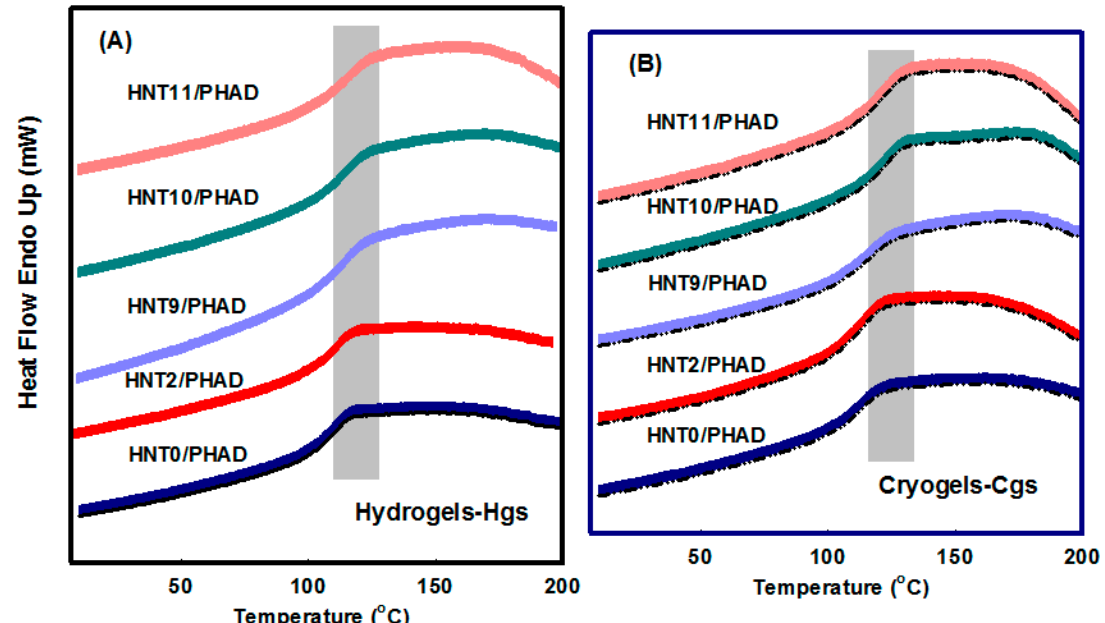
Figure 3. DSC curves of HNT-free, HNT0/PHAD, and ternary hybrid HNTm/PHAD Hgs ( A ) and those of Cgs ( B ) prepared at HNT content of 0%, 0.50%, 2.50%, 2.80%, and 3.20% ( w / v ). Gray highlighted area indicates the region where T g temperatures are determined. Table 3. T onset , T g , and ∆ C p values of HNT-free, HNT0/PHAD, and ternary hybrid